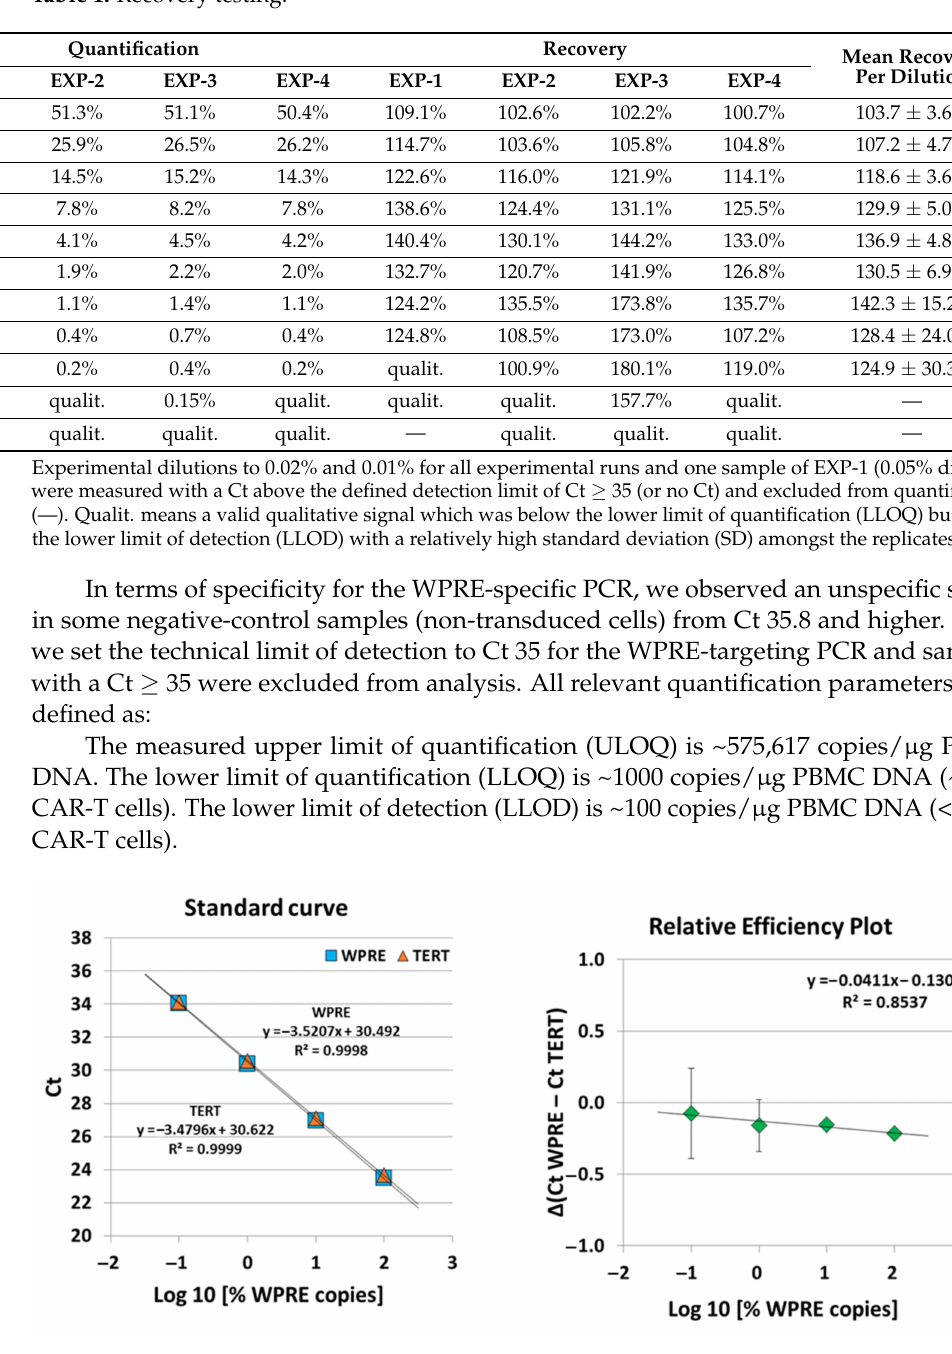
Figure 5. Standard curves and relative-efficiency plot of duplex qPCR reactions targeting WPRE and TERT in H 2 O standards (semi-logarithmic display; x -axis: % WPRE copies (log 10); y -axis: threshold cycle (Ct)). Exemplary data from one validation experiment are displayed. Mean Ct values from qPCR were used for linear regression. Reactions were performed in triplicate. qPCR: quantitative polymerase chain reaction. The relative-efficiency plot compares simultaneous PCR reactions over the tested Ct range by calculation of ∆ (Ct WPRE − Ct TERT) and the use of graphical analysis (semi-logarithmic display; x -axis: % WPRE copies (log10); y -axis: ∆ Ct). Exemplary data from one validation experiment are shown. Mean Ct values from qPCR were used for ∆ Ct calculations. Results are represented as mean ± standard deviation (SD). Reactions were performed in